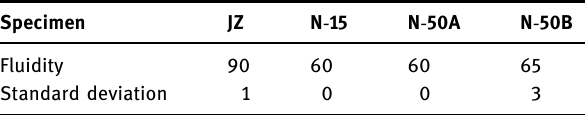
Table 3: E ff ect of NS on the fl uidity of specimens ( mm )